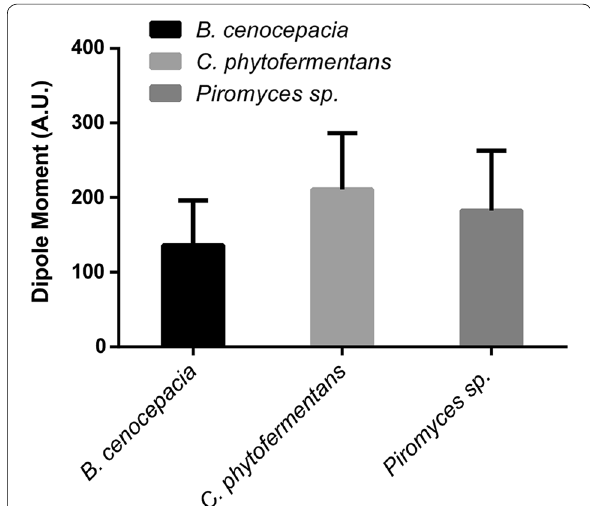
Fig. 5 Dipole moment representing the net protein charge. All proteins atoms charge and topology were used to calculate the protein electric vector under similar conditions to the enzymatic assay. Statistical analyses of the data shown were performed with one-way ANOVA test and have shown a p value < 0.001. n models analyzed